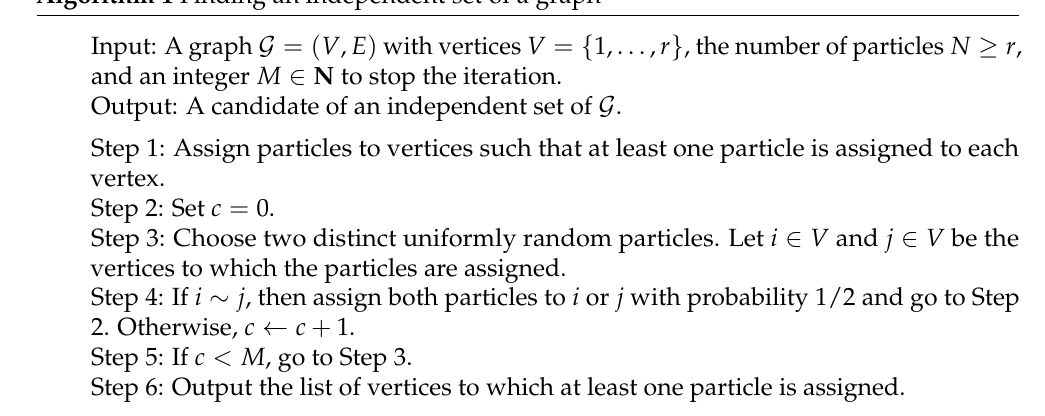
Algorithm 1 Finding an independent set of a